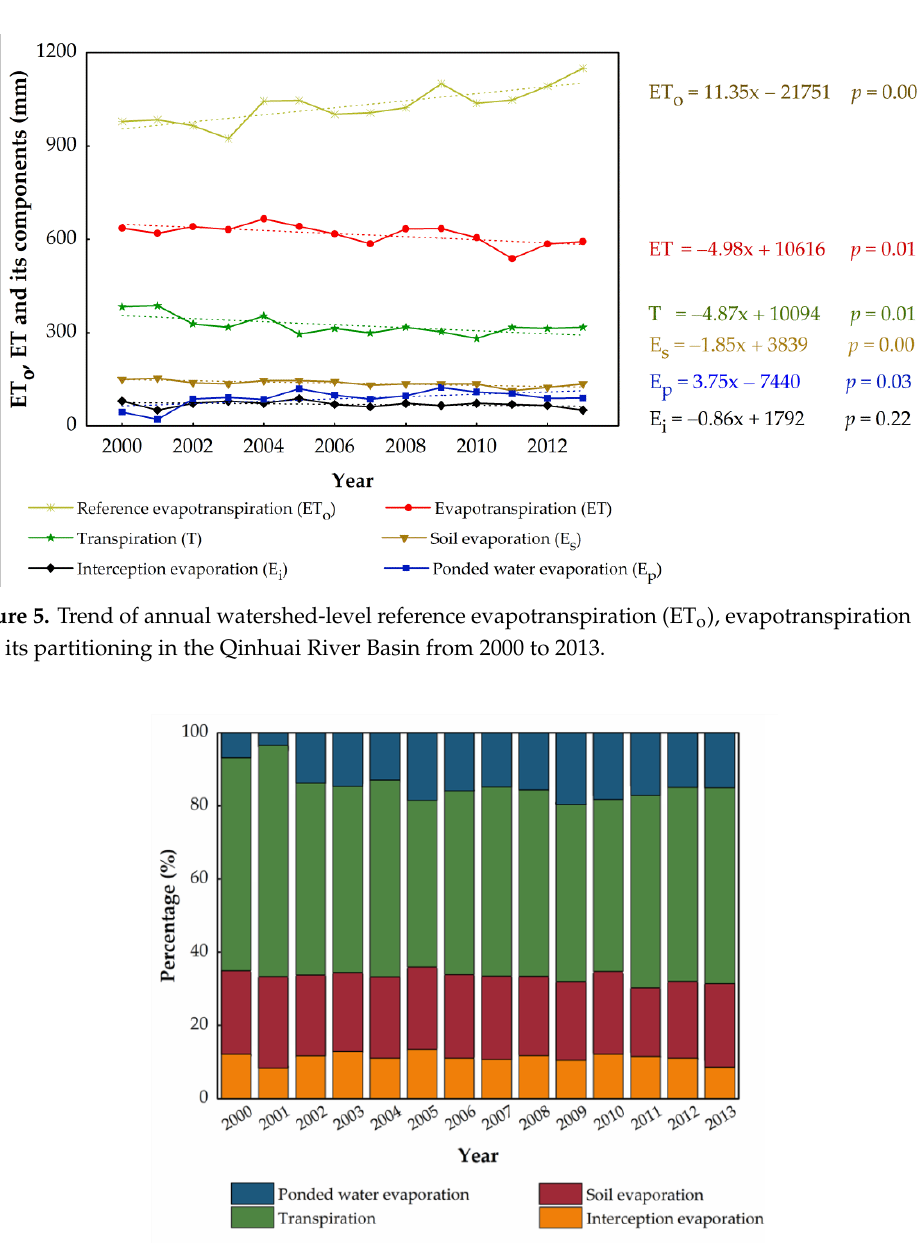
Figure 6. Simulated mean annual proportion of evapotranspiration partitioning in the Qinhuai River Basin from 2000 to 2013.